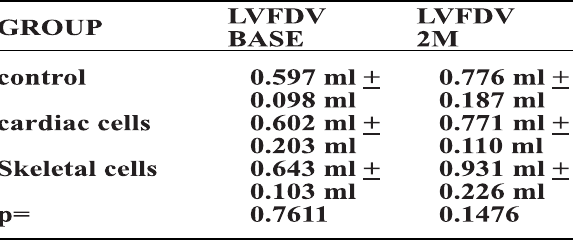
Table 2. LVFDV mean echocardiográphic